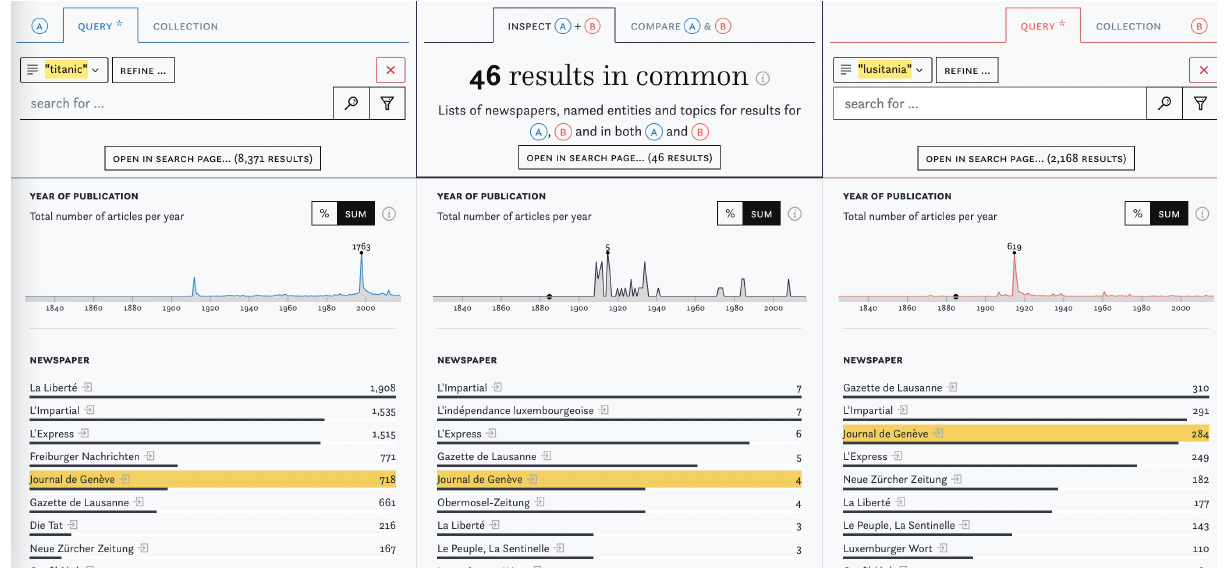
Figure 1. Overview of the I&C interface with an example query for “titanic” and “lusitania”.